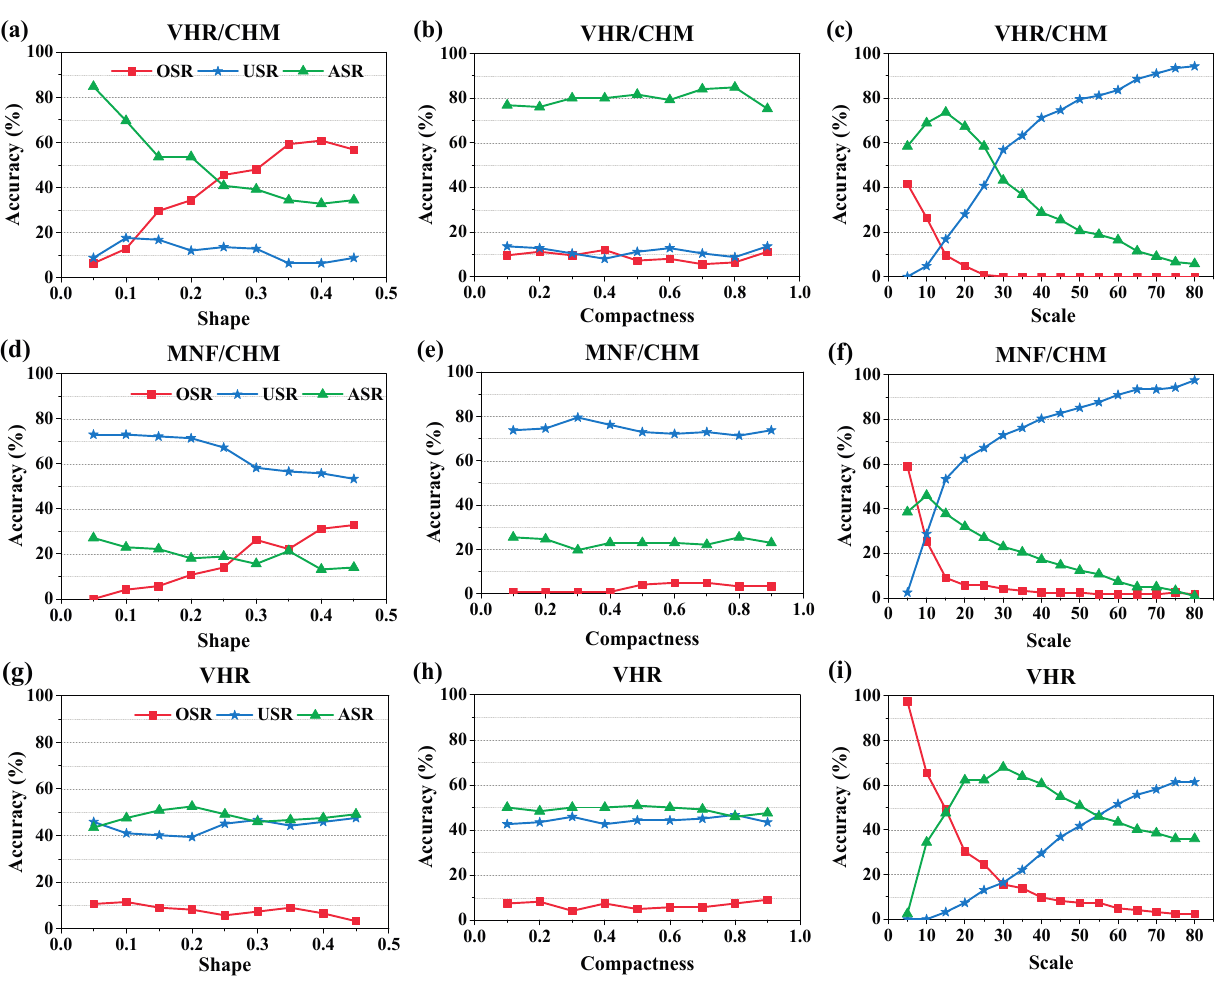
Figure 10. Image segmentation parameters and their corresponding segmentation accuracies. ( a – c ) are segmentation parameters of VHR/CHM data integration; ( d – f ) are segmentation parameters of MNF/CHM data integration; and ( g – i ) are segmentation parameters of VHR data. In (a), (d), and (g), the best segmentation result will be obtained within the shape parameter range, and the corresponding shape parameter will be chosen as the optimum shape parameter for its segmentation scheme. Similarly, the optimum compactness and scale parameters will be achieved from the results shown in (b), (e), (h) and (c), (f),